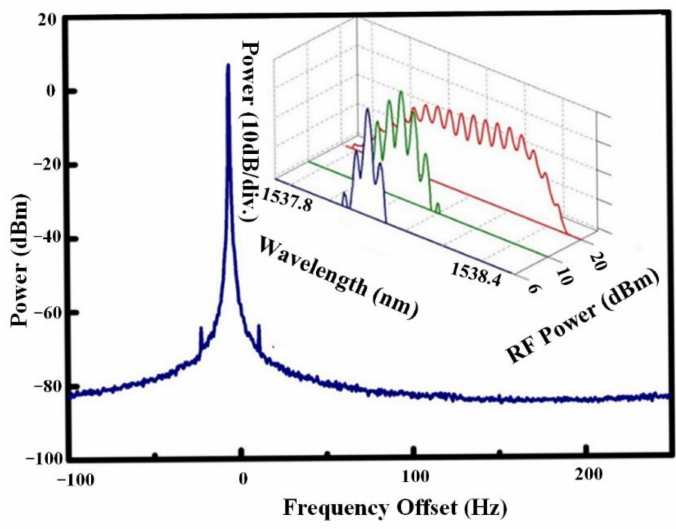
Figure 3. A generated RF signal’s output spectrum and laser output vs. RF